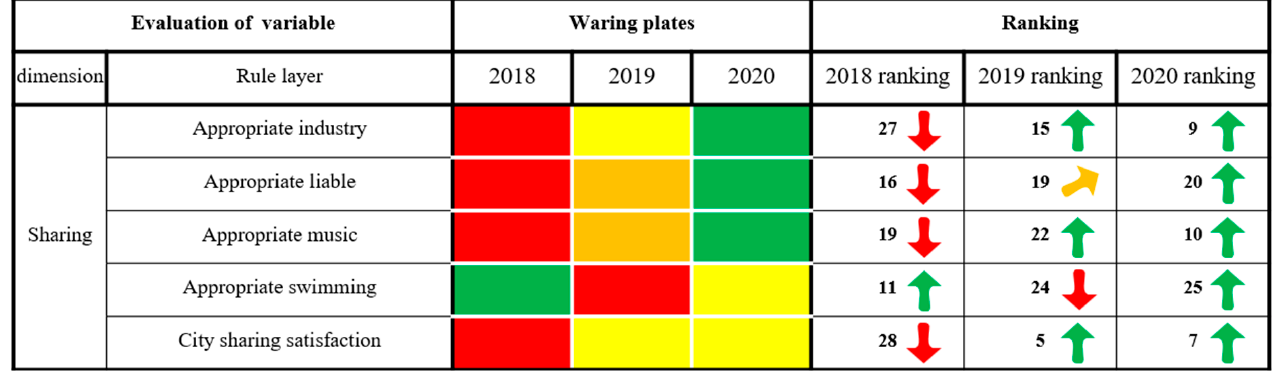
Figure 11. The results of the sharing dimension of city health examinations and evaluations in Xining City.